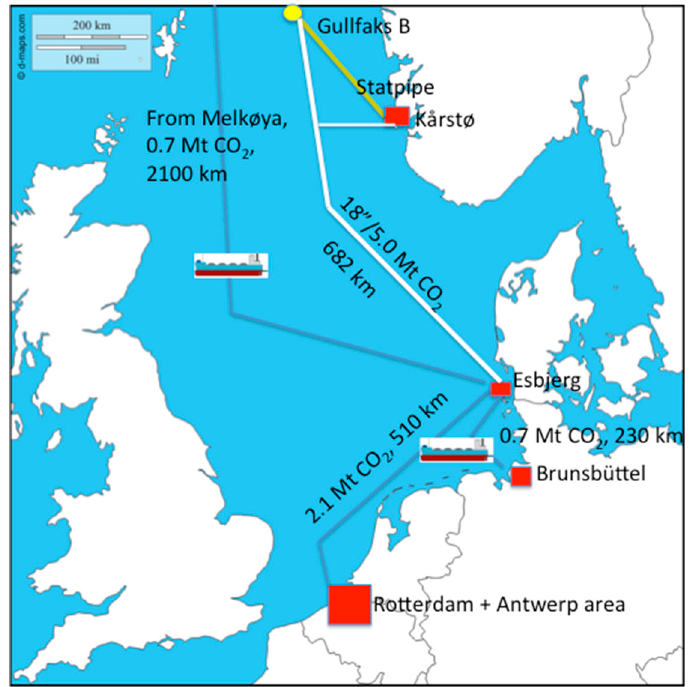
Figure 7. A network of sources and transportation means to supply Gullfaks with 5.5 Mt CO 2 / year. Schematic figure based on [22,23].